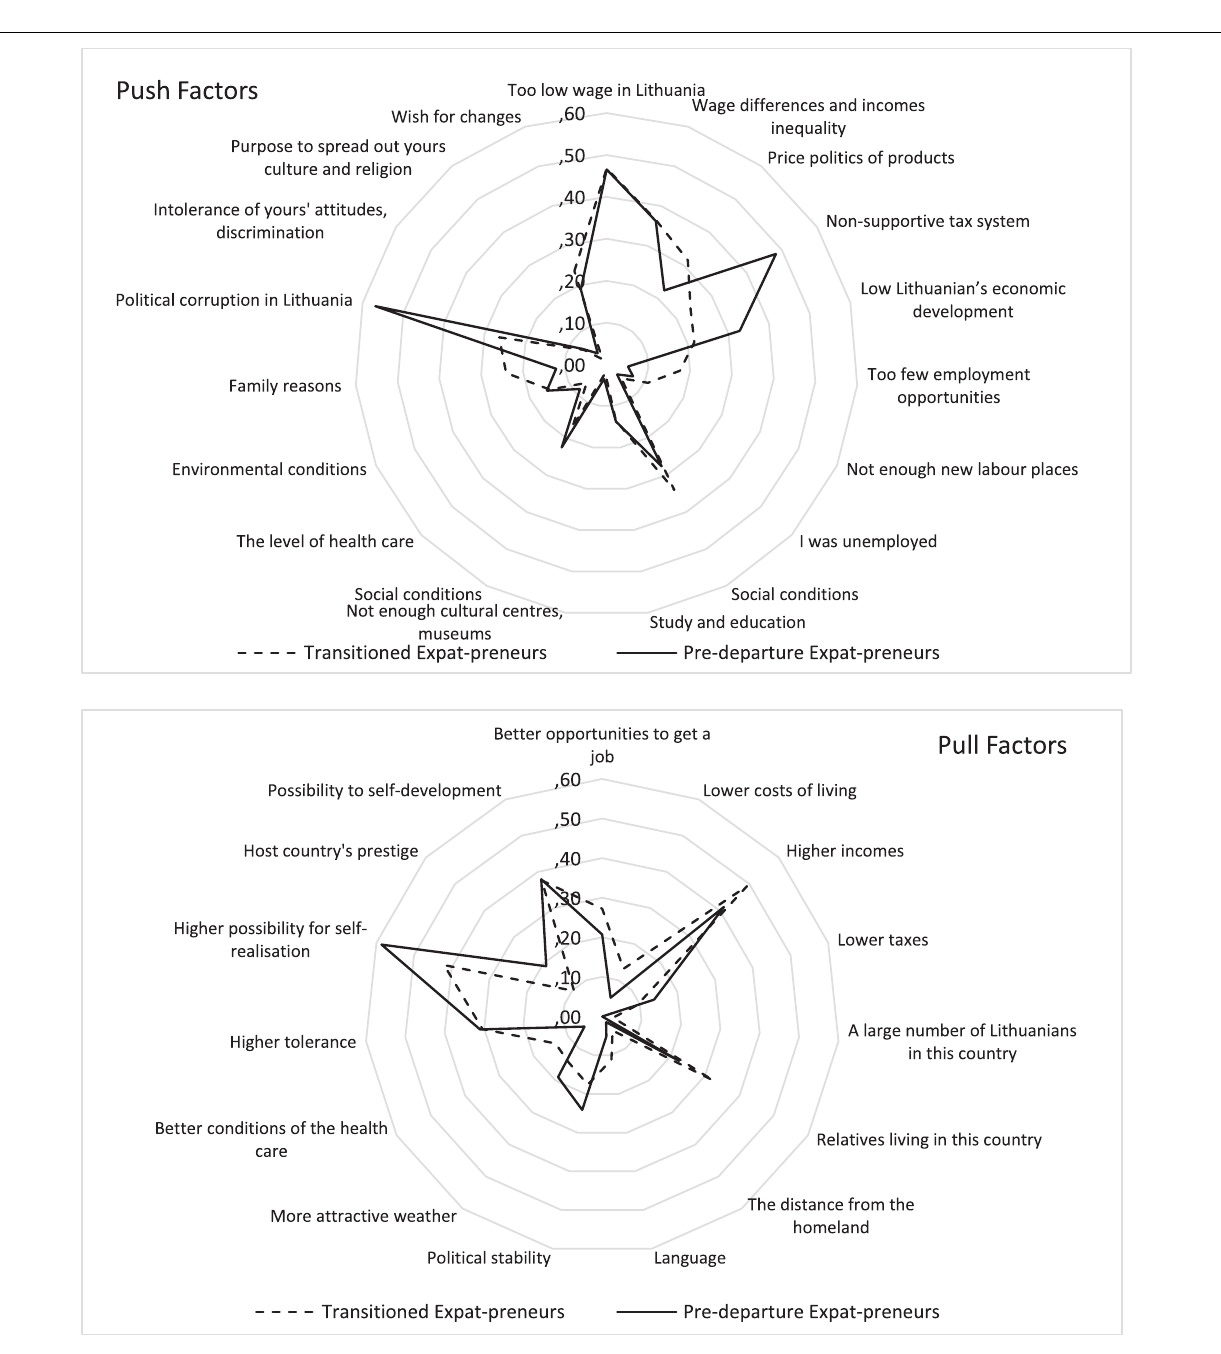
United States #22 in 2015. Summing up, based on